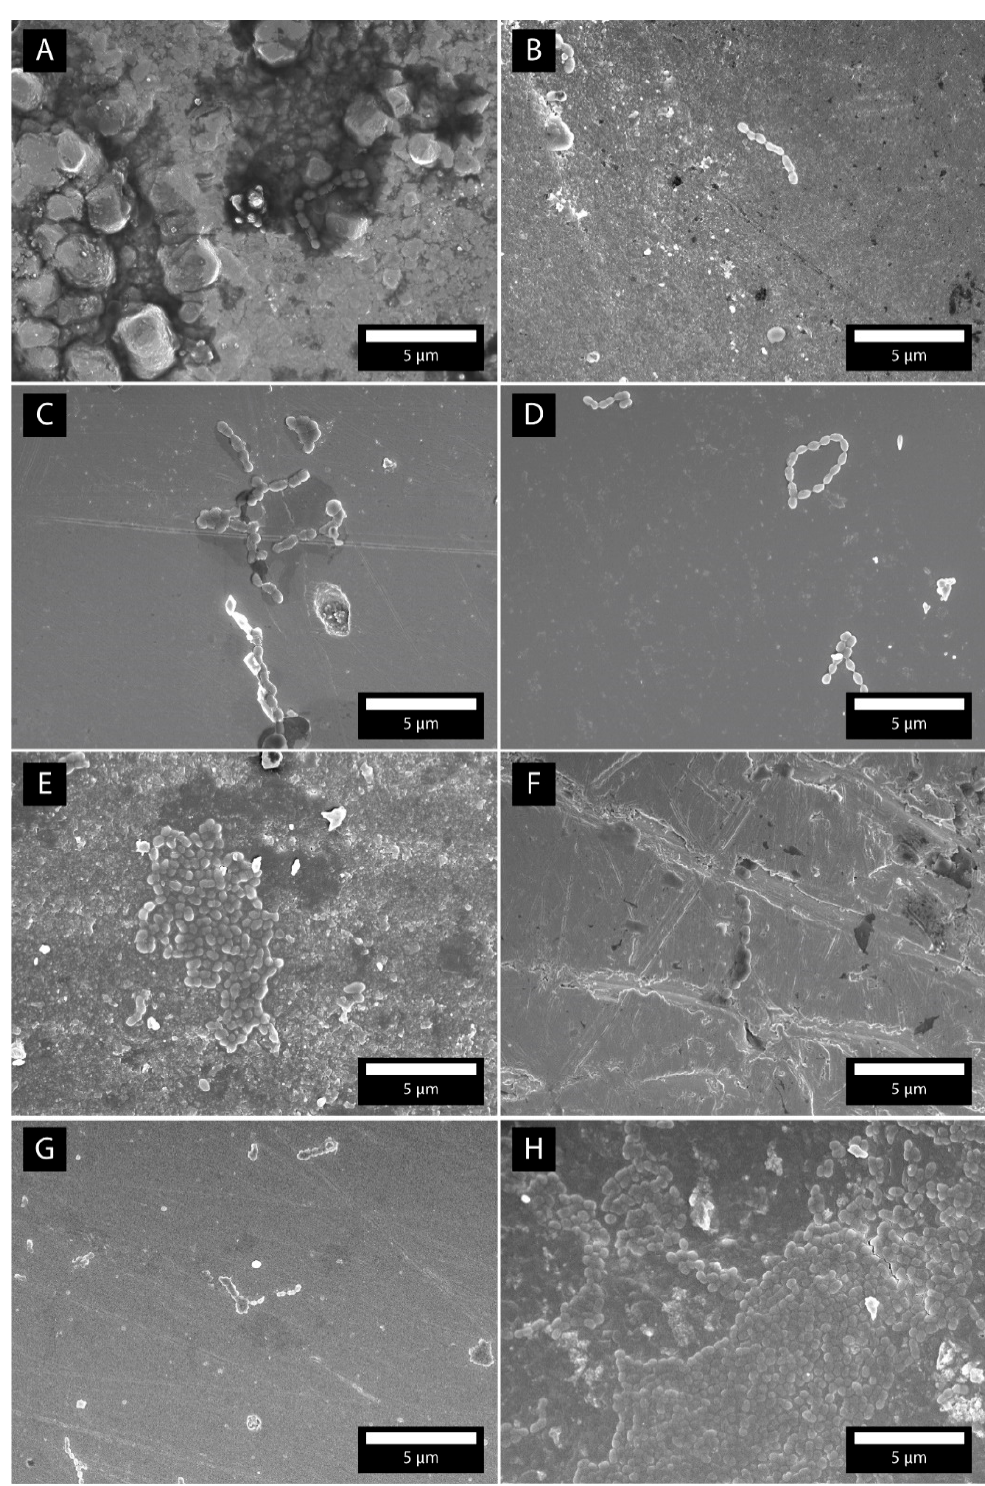
Figure 5. SEM micrographs of the bacteria S. mutans after 10 h of incubation time. The micrographs are made on amalgam ( A ), Chromasit ( B ), Co-Cr alloy ( C ), IPS InLine ceramic ( D ), resin-based composite ( E ), Au-Pt alloy ( F ), TPZ ceramic ( G ), and tooth ( H ).